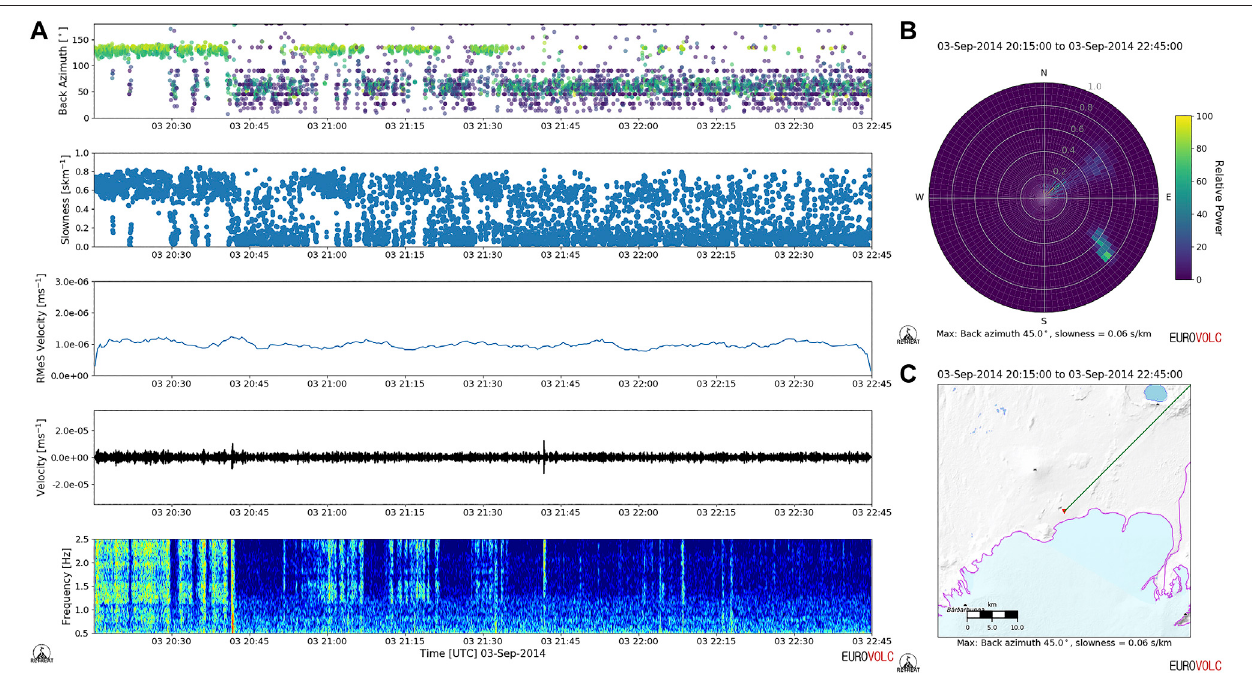
FIGURE 9 | Output fi gures produced by the RETREAT software that illustrate its capacity to analyze time periods containing multiple tremor sources. (A) Time series of slowness and backazimuth calculated from f-k analysis, alongside the seismic waveform, envelope and spectrogram showing a switch from one dominant source to another during this time period. (B) A polar representation of the array processing results, with the histogram highlighting the two tremor sources to the north- eastandsouth-eastofthearray.Alsoshownis (C) amapoftheareasurroundingtheURarray,withtheazimuthofthemoredominantsource,associatedwithlava fl ows at the surface,